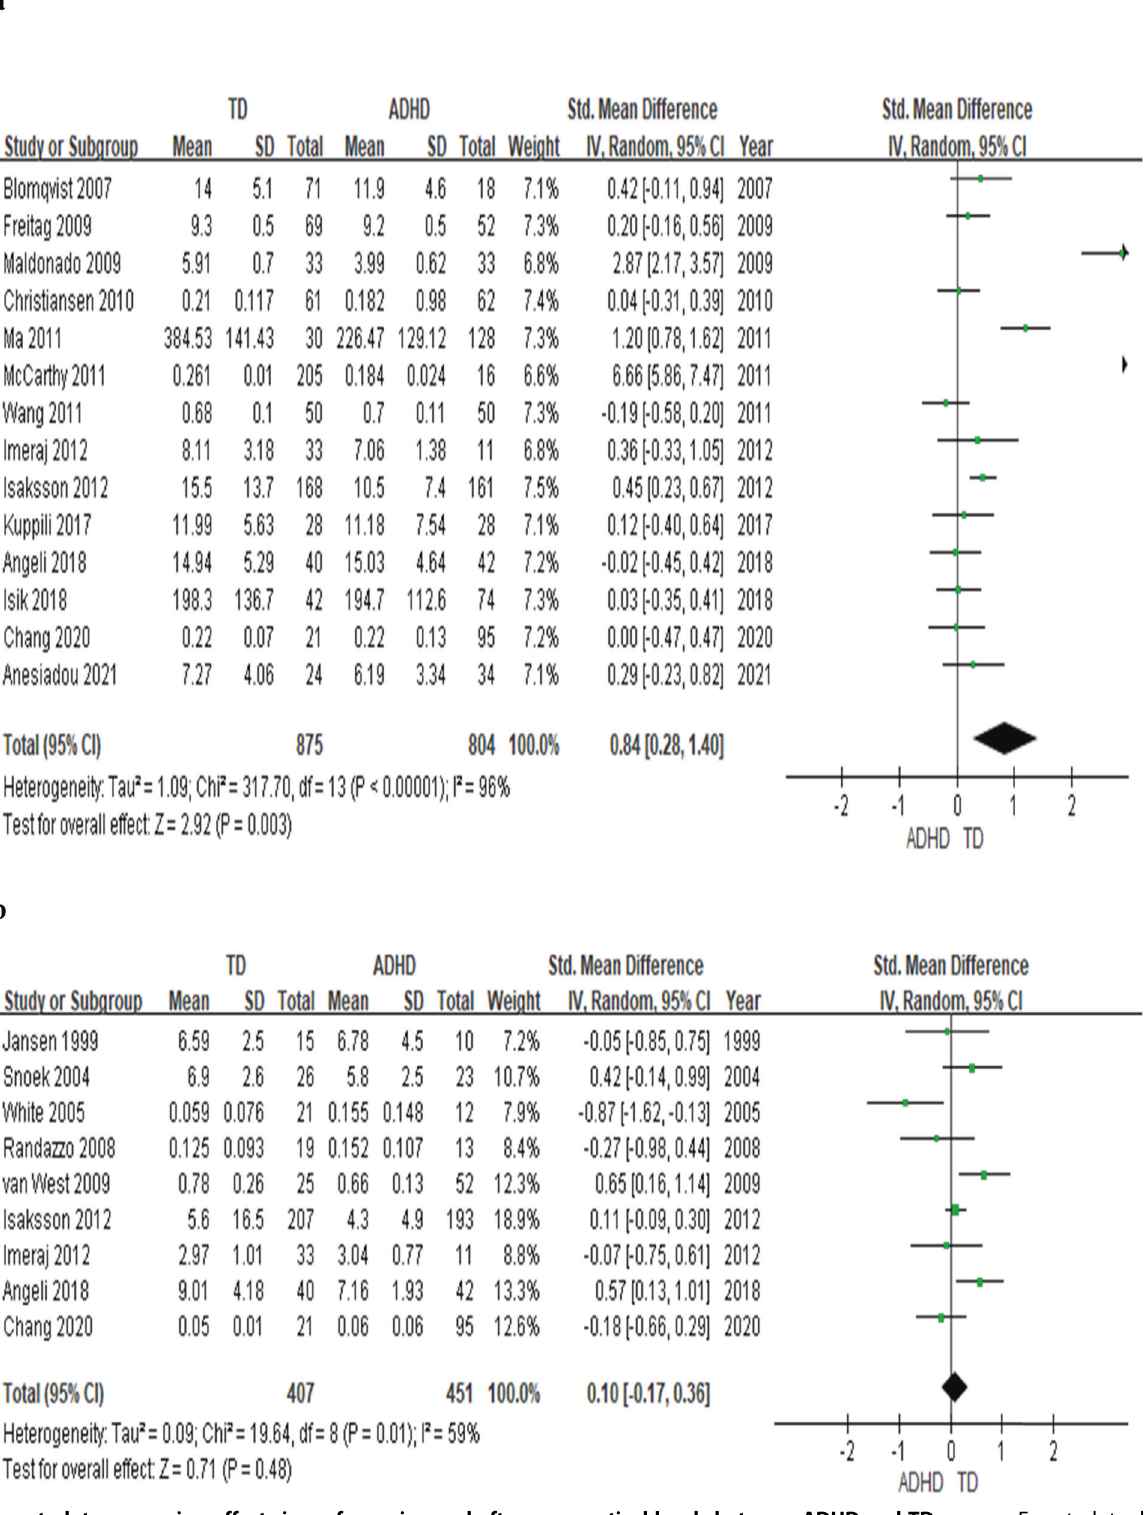
Fig. 2 Forest plots comparing effect sizes of morning and afternoon cortisol levels between ADHD and TD groups. Forest plots showing effect sizes (Hedges ’ s g) and 95% con fi dence intervals (CIs) from individual studies and pooled results comparing ( a ) morning and ( b ) afternoon cortisol levels between ADHD population and TD group. Note, ADHD attention de fi cit hyperactivity disorder, CI con fi dence interval, Std standard, TD typically developing